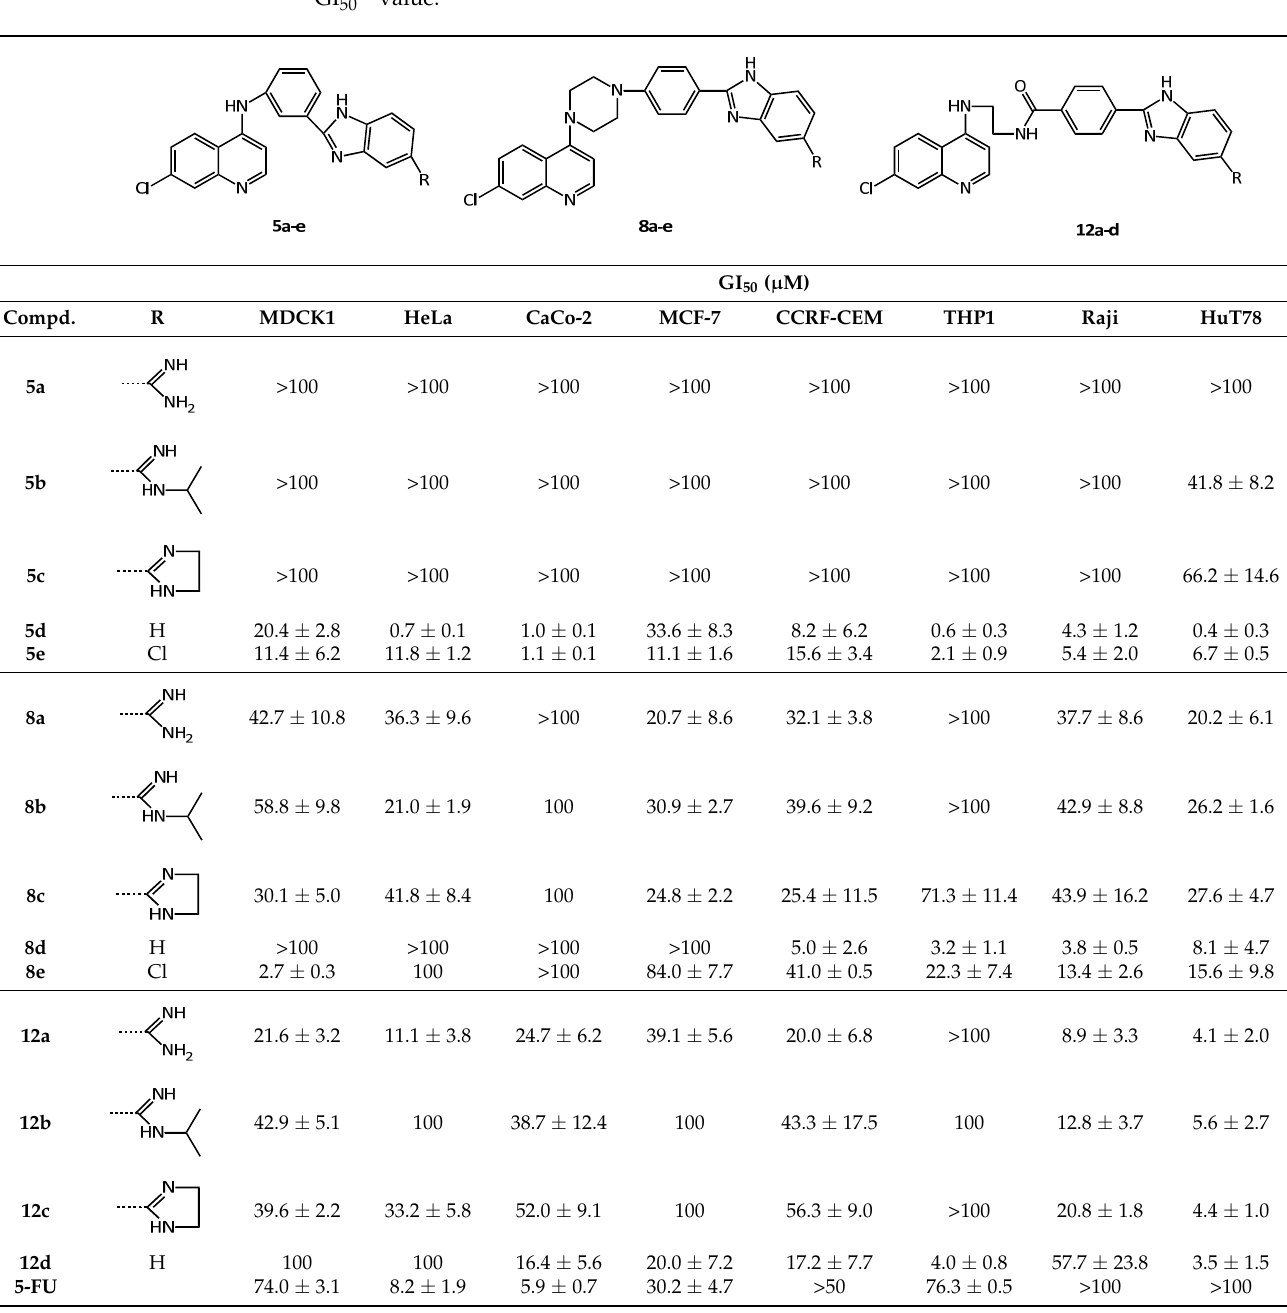
Table 1. Sensitivity of human tumor and normal cells to investigated compounds expressed as GI 50a value.